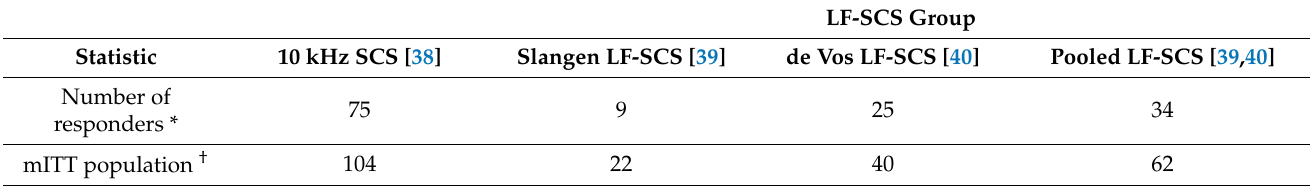
Table 3. Comparison of the mITT population responder rates at 6